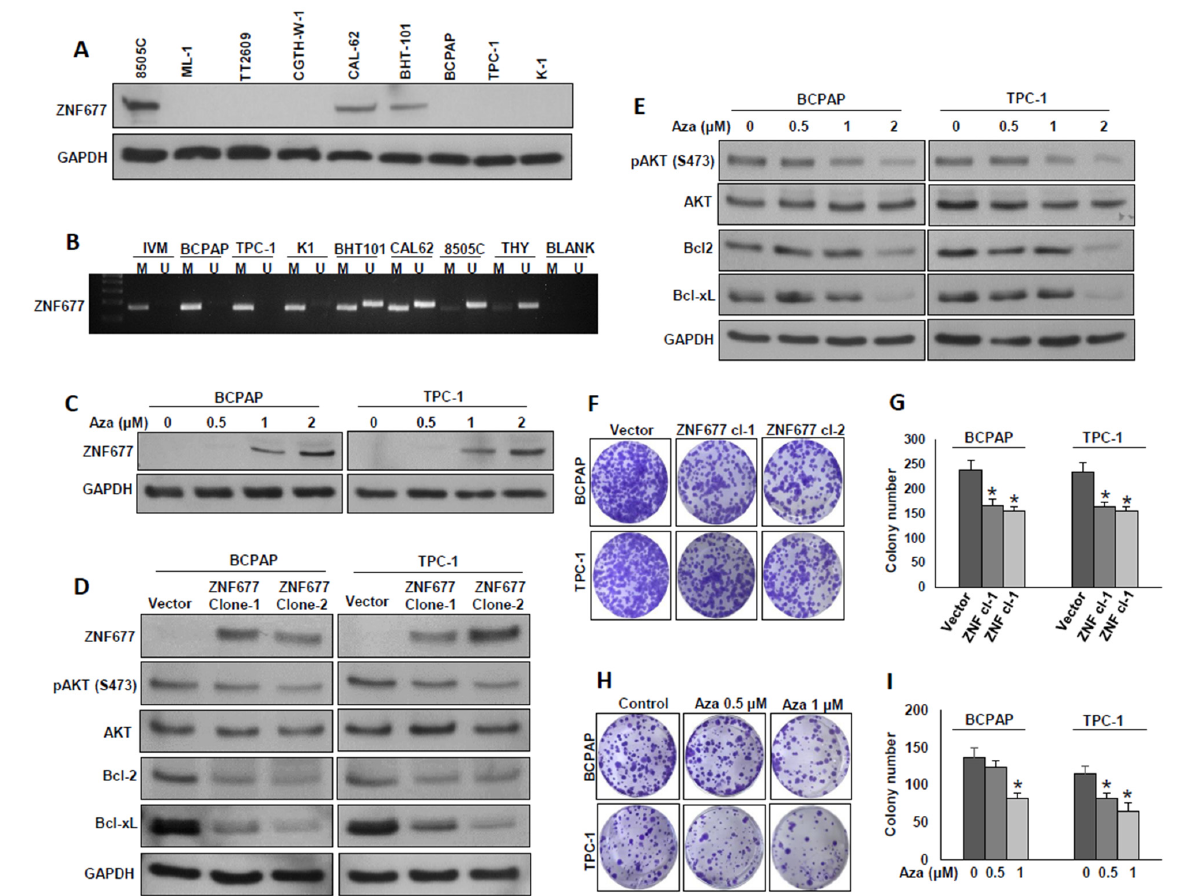
Figure 3. ZNF677 inhibits PTC cell growth in vitro. ( A ) Basal expression of ZNF677 in a panel of thyroid cancer cell lines. Proteins were isolated from nine thyroid cancer cell lines and immunoblotted with antibodies against ZNF677